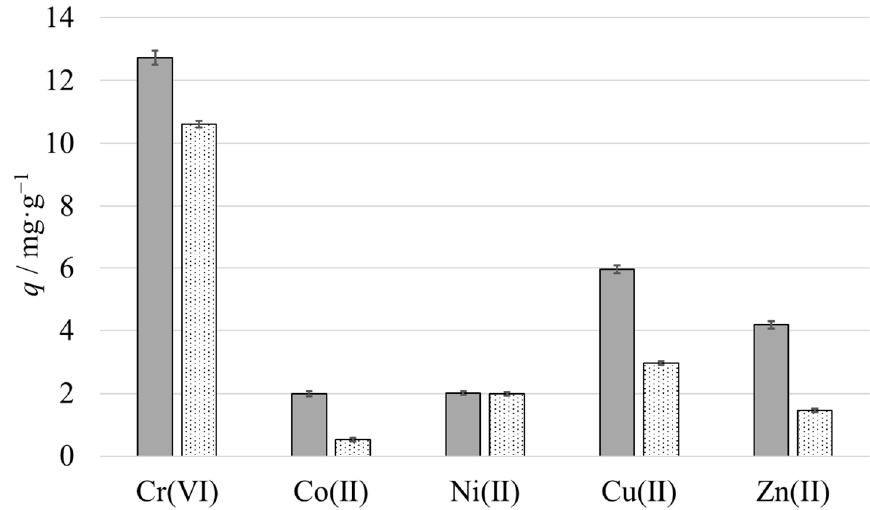
Figure 4. Graph showing the metal ion extraction capacity q e (solid bars) and the metal ion recovery capacity q r (dotted bars). Error bars represent ± 1 σ .